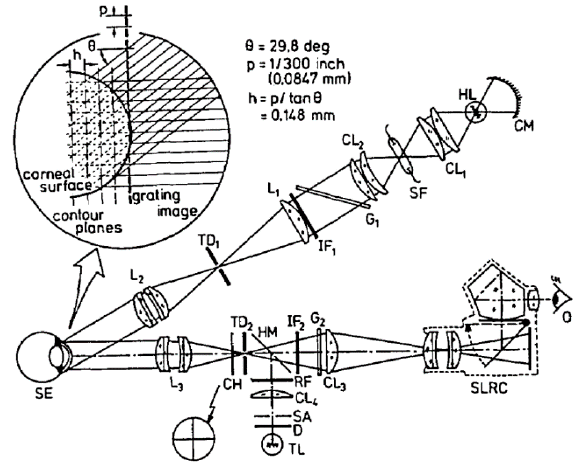
Figure 7. Schematic diagram of Kawara’s design [63].